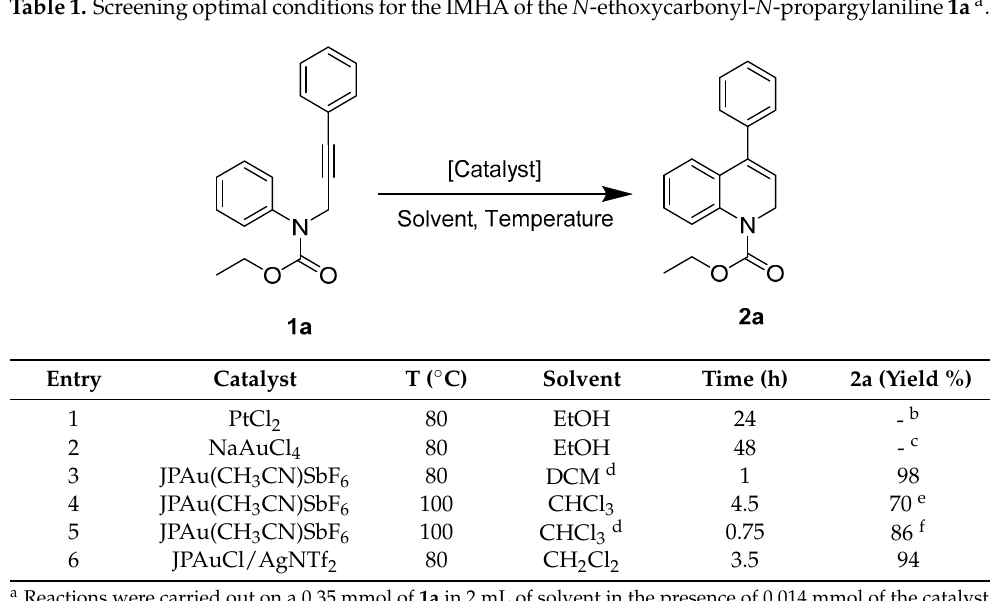
Molecules 2021 , 26 , x FOR PEER REVIEW